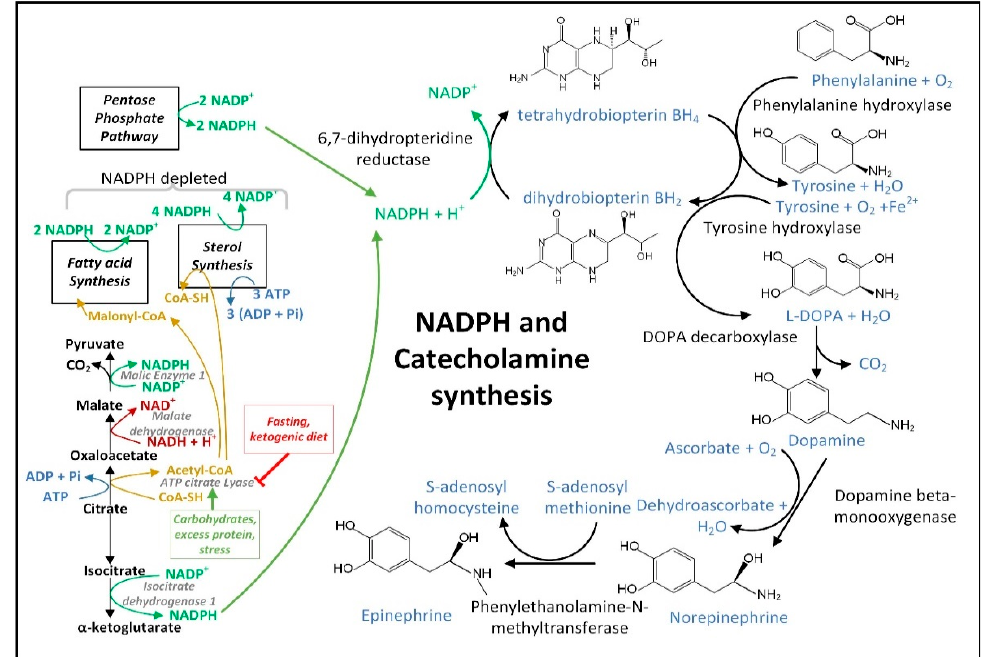
Figure 7. NADPH and BH 4 are required for the synthesis of dopamine, norepinephrine, and epinephrine. Fasting likely diverts more cytoplasmic citrate to isocitrate, which is metabolized by IDH1 to increase cytoplasmic NADPH levels, while carbohydrate consumption activates ATP ‐ citrate lyase metabolism of cytoplasmic citrate to increase fatty acid synthesis, which depletes cytoplasmic NADPH.